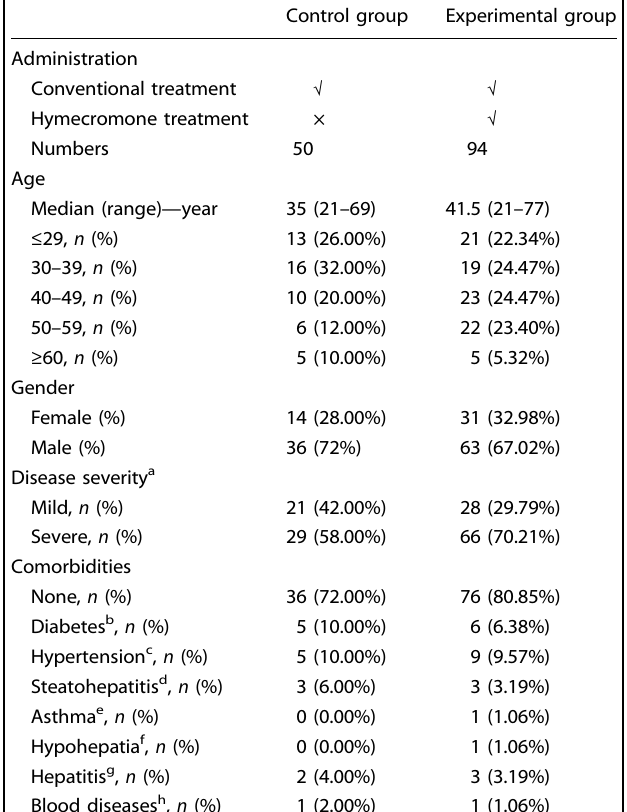
Table 2. The clinical features of enrolled patients and subgroups Control